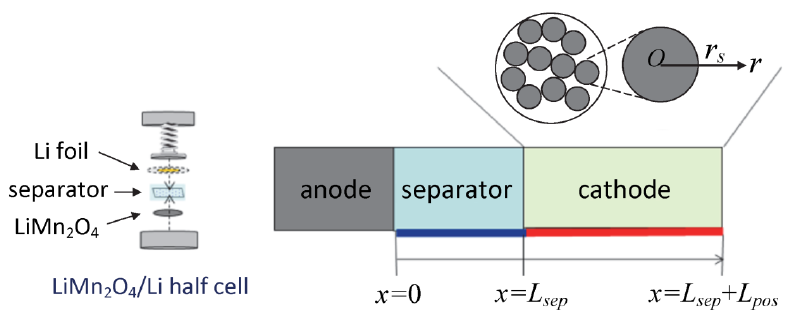
Figure 1. Configuration of the LiMn 2 O 4 /Li half-cell for experiments and simulations. Table 2. Key parameters of the cathode electrode, electrolyte, and separator in the electrochemical model.